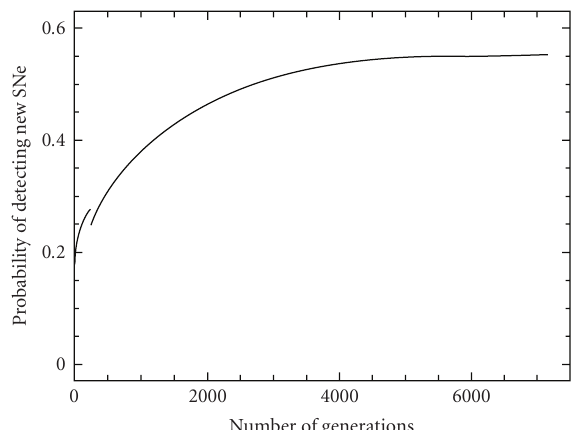
Figure 3: Evolution of the probability of detecting new supernova with the number of generations. In this example, every generation consists of a population of 1,000 observational plans, where each observational plan contains hundreds of 60 sec exposures to di ff erent targets. For the simulation, we have used the gold sample of galaxies of the CHASE survey [8], where the distances were computed from recession velocities. Event rates were created randomly at the beginning of the simulation to reproduce the typical rates expected for supernova explosions. The cadences were randomly generated to reproduce the typical values expected in the CHASE survey.